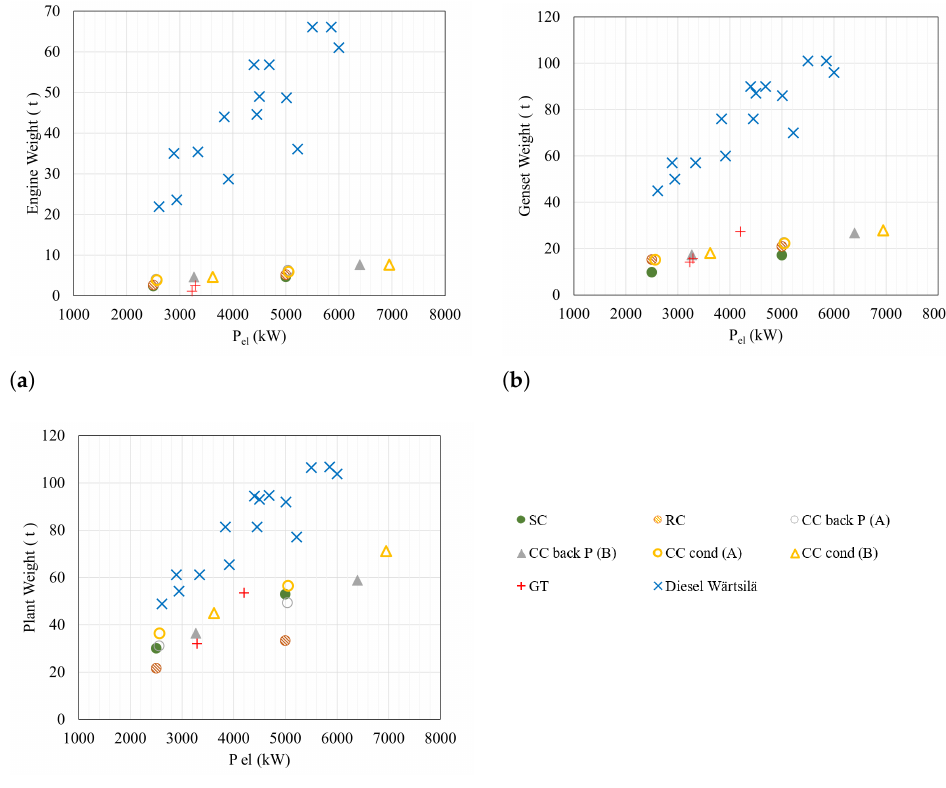
Figure 4. Weight comparison for engines alone ( a ), gensets packages ( b ) and all components ( c ) for Mini Gas Turbines, commercial naval GT and Diesel Engines. Graphs are not on the same scale for ease of